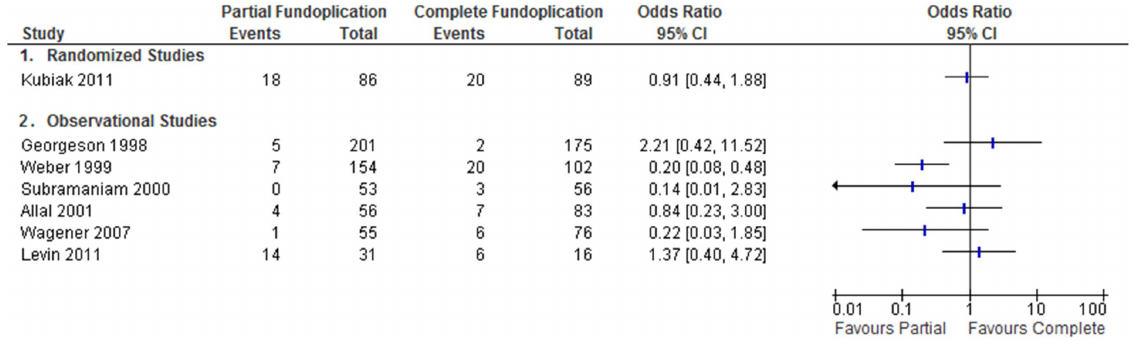
Figure 5. Dysphagia following partial versus complete fundoplication.